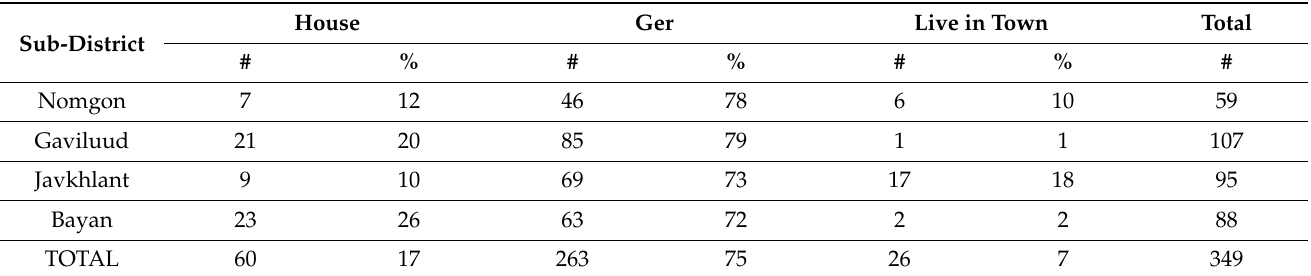
Table 5. Herder households by type of dwelling—ger (tent yurt) or fixed